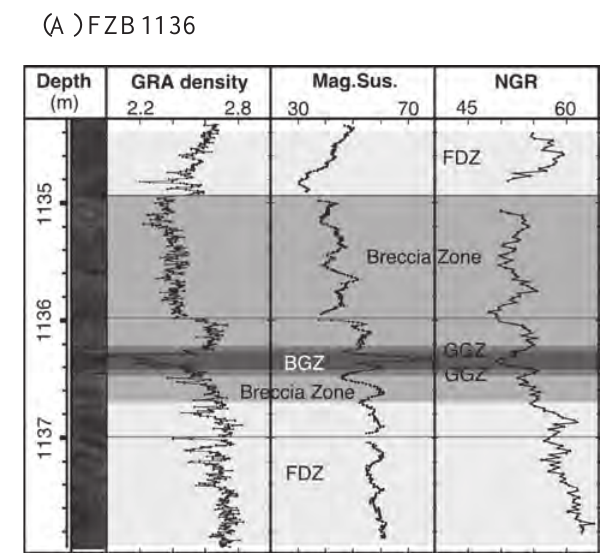
Figure 2 Density, magnetic susceptibility (Mag Sus), and natural gamma ray radiation (NGR) logs from [A FZB1136, [B] FZB1194, and [C] FZB1243. The units are g cm -3 , 10-5SI, and cps, respectively. FDZ, fracture-damaged zone; BGZ, block gouge zone; GGZ, gray gouge zone (Hirono et al.,